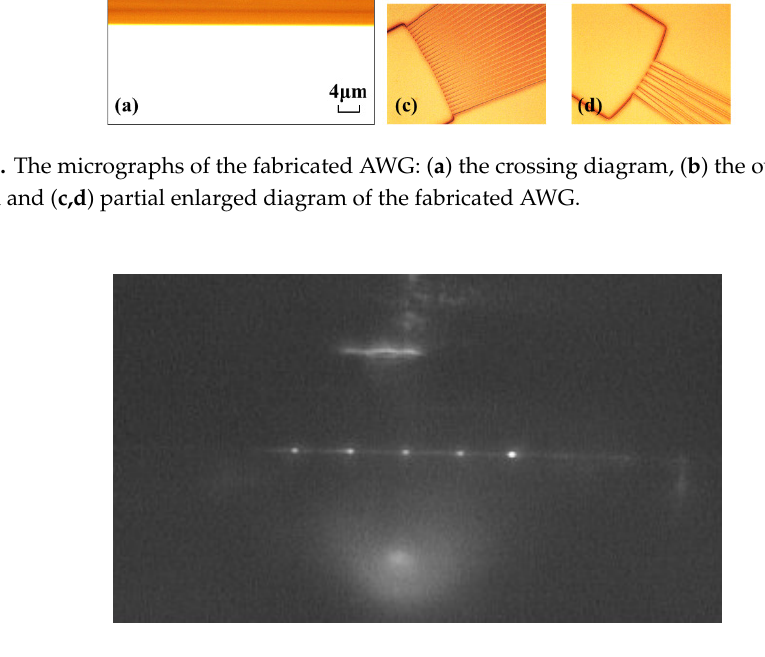
Figure 6. Near-field guided-mode patterns of the AWG.